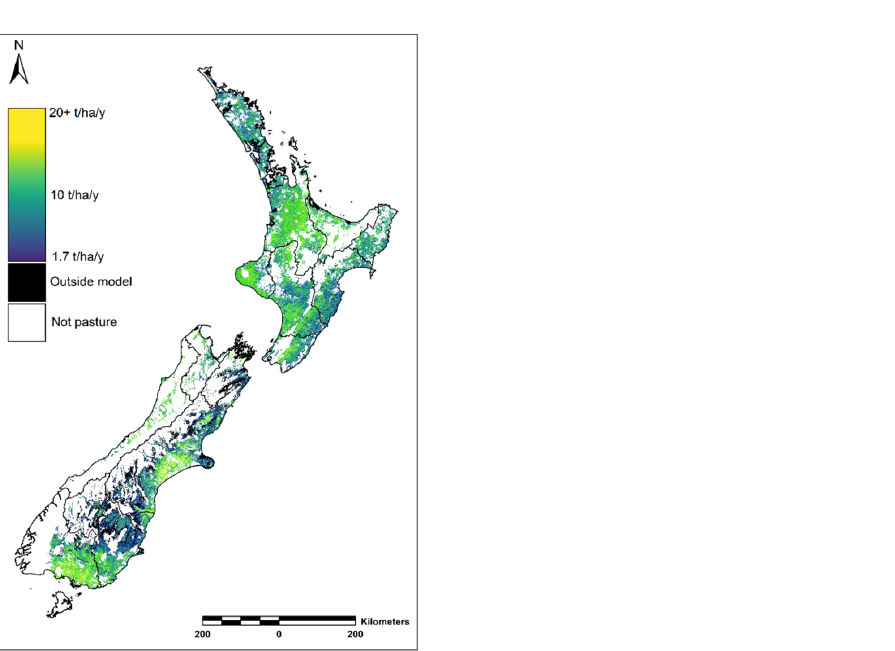
Figure 6. A national map of median NDVI, omitting dates for each pixel where the NDVI is nega- tive. Regional boundaries are shown in black.